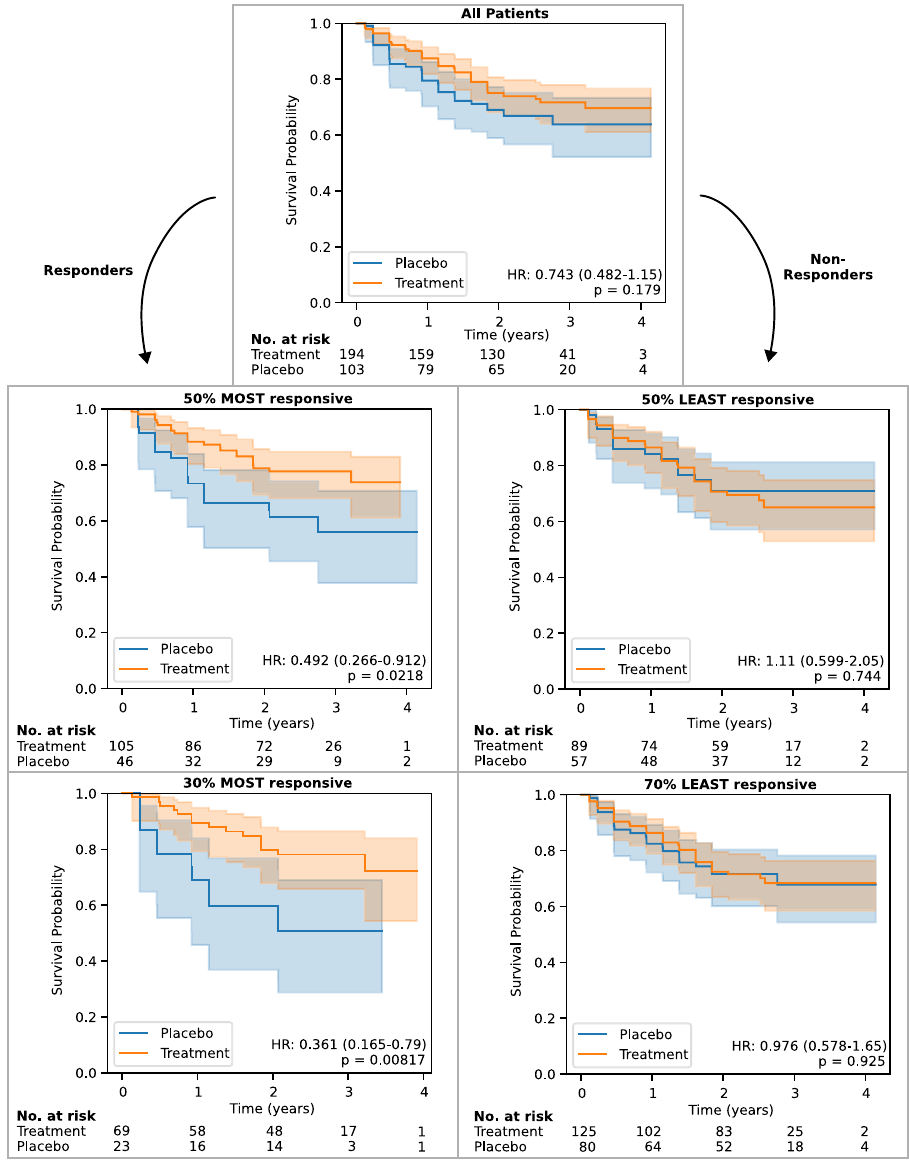
Fig. 2 | Kaplan – Meyer curves ±95% con fi dence intervals (CI) for predicted responders and non-responders to anti-CD20-Abs in the held-out test set, de fi ned at two thresholds of predicted effect size. These are compared to the wholegroup(top).Theplacebogroupisdisplayedinblue,andthetreatment(anti-